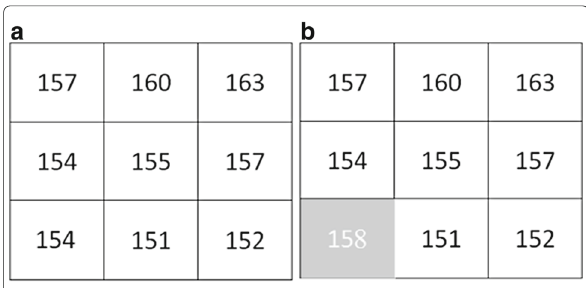
Fig. 1 Noise caused by local intensity fluctuation. a Original texture. b Texture changed due to local intensity fluctuation